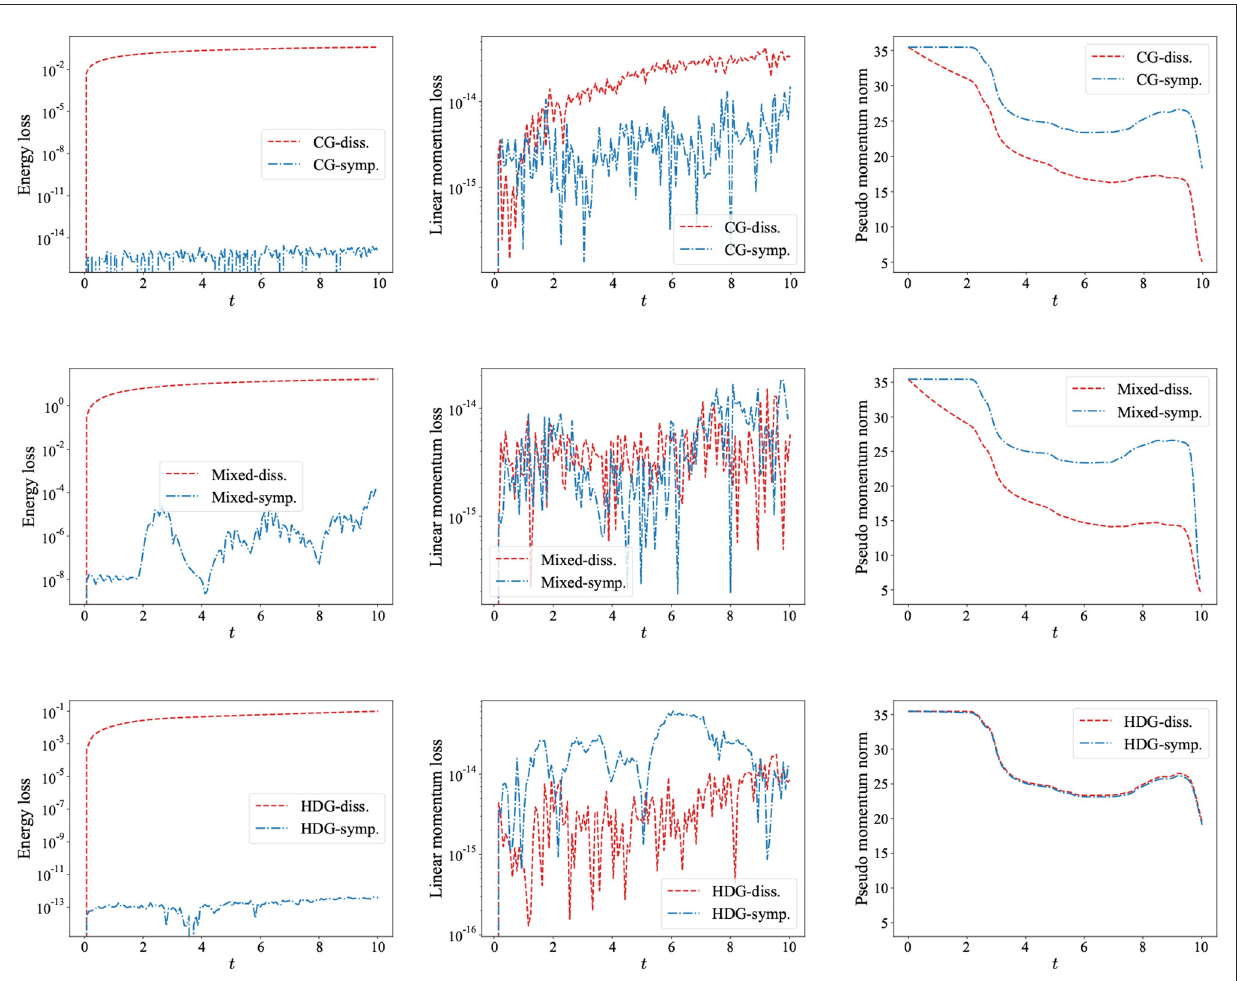
FIGURE4 Plots of the approximated physical quantities: Energy loss (left) , linear momentum loss (middle) , and pseudomomentum. The first row shows a comparison of the continuous Galerkin methods using the implicit midpoint (dot-dashed blue line) and an sDIRK method of order 3 (dashed red line). The second row shows a comparison of the Mixed method using the Raviart-Thomas element with a polynomial approximation of order 3, using the Störmer-Verlet scheme and the sDIRK method of order 3. The third row shows a comparison of the Hamiltonian HDG scheme (Equation 13) and the dissipative HDG scheme (Equation 12), for both we use the implicit